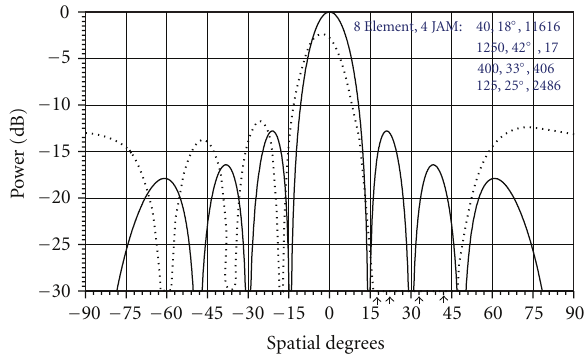
Figure 14: Validation for the interference suppression for four nar- rowband sources located in sidelobe region. Compare Gabriel